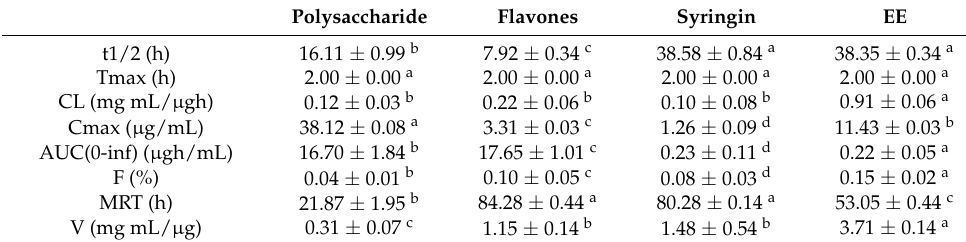
Figure 5. Pharmacokinetic curve of functional components of Acanthopanax senticocus in brain tissue. ( A ) Pharmacokinetic curve of ASPS; ( B ) pharmacokinetic curve of EE; ( C ) pharmacokinetic curve of flavones; ( D ) pharmacokinetic curve of syingin. Table 2. Pharmacokinetics parameters of AS component in brain.